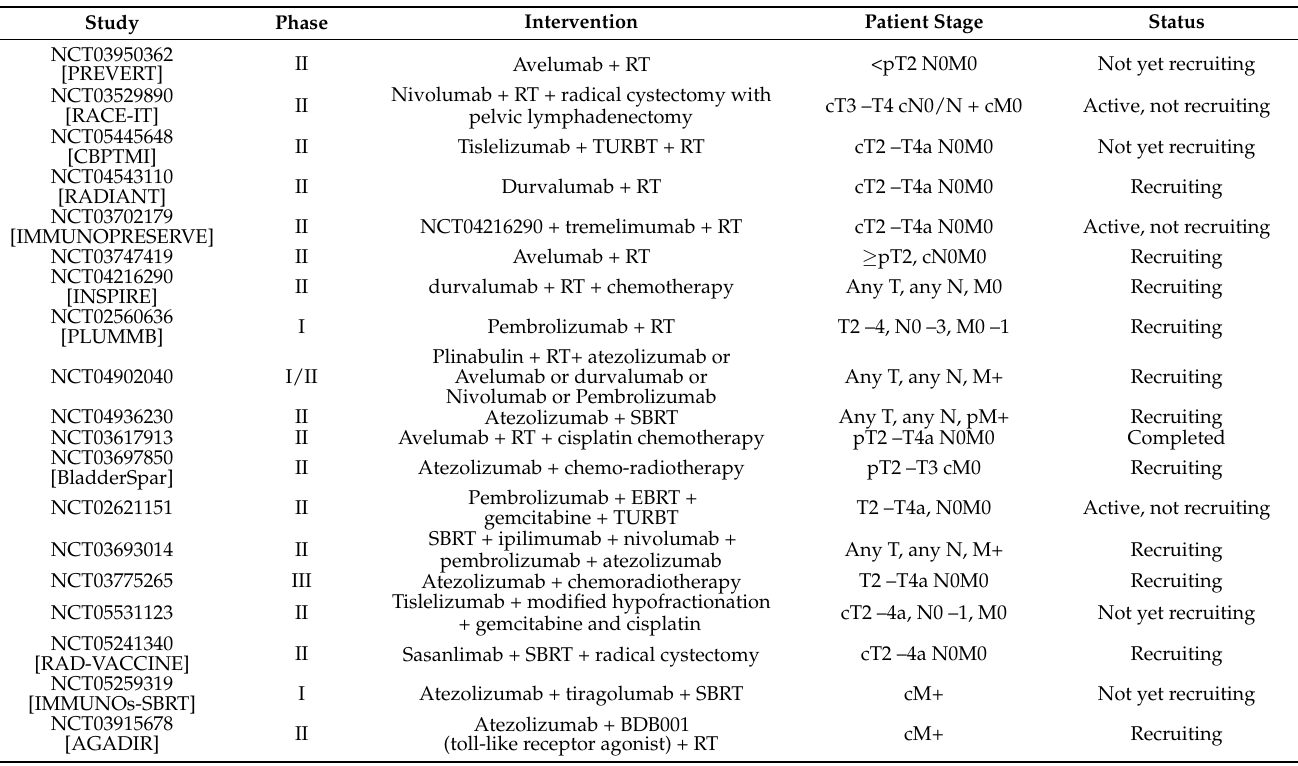
Table 1. Clinical Trials of Immunotherapy and Radiotherapy in Bladder